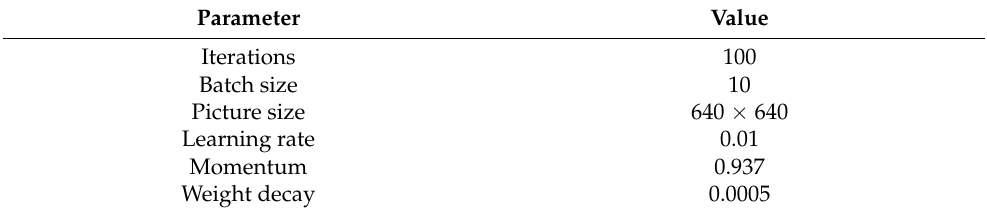
Table 2. The experimental setting on algorithm parameter and its